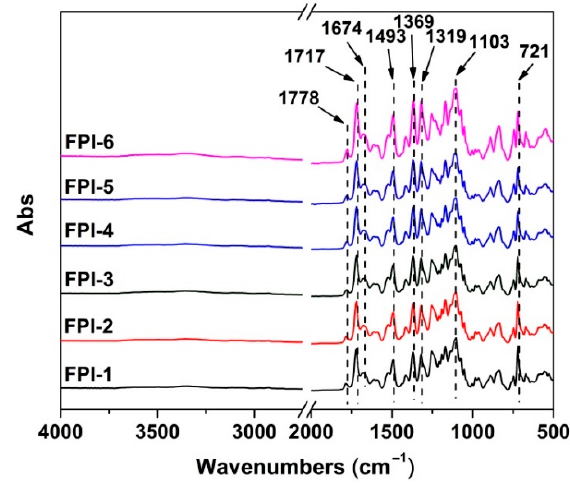
Figure 4. FTIR spectra of FPI films.